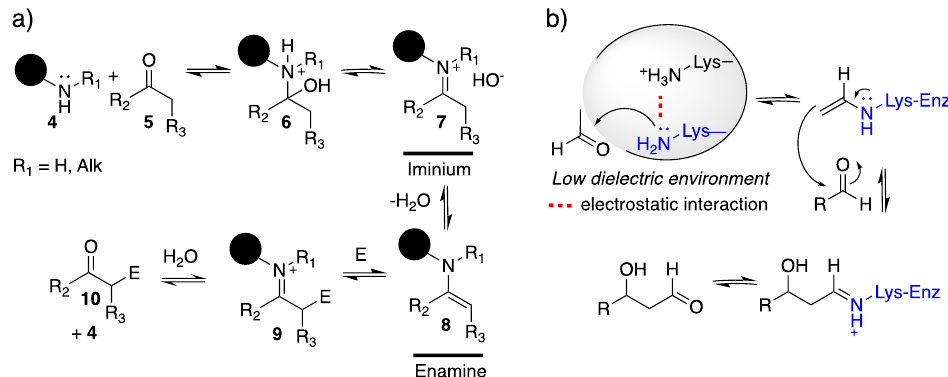
Figure 1. ( a ) Schematic mechanism of the enamine catalysis. E = electrophile. ( b ) General class I aldolase mechanism. Reactivity of the Schiff base-forming lysine is enhanced by two principal ways, a low dielectric environment and electrostatic interaction with a nearby positively charged residue.